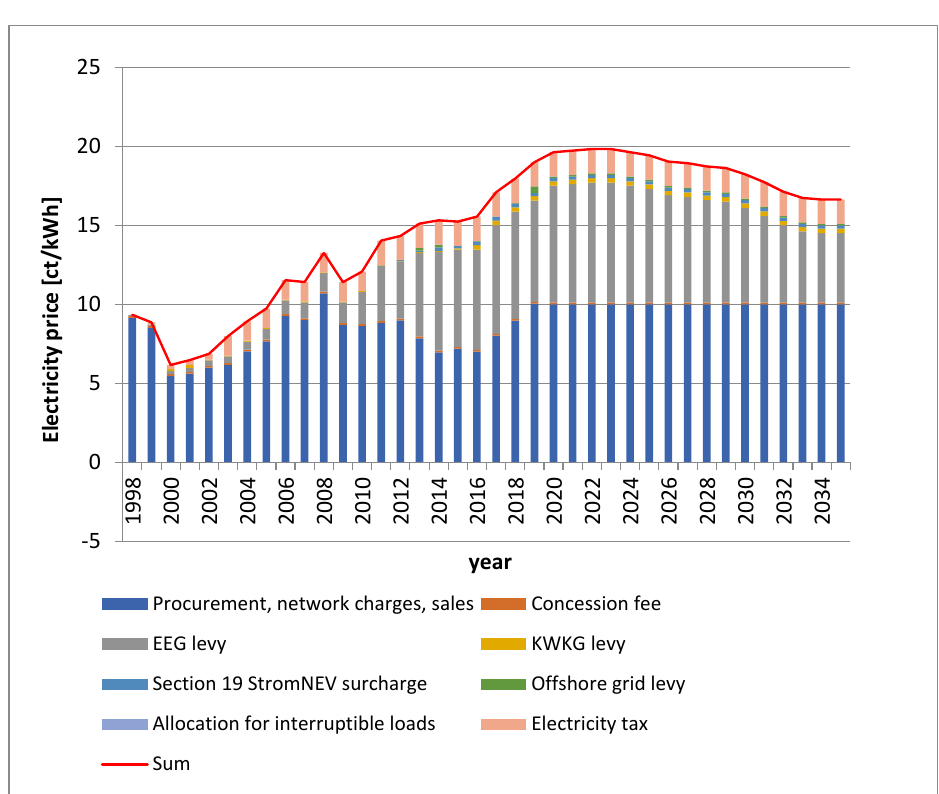
Figure 9. BDEW electricity price analysis 1998 – 2019 and EEG surcharge changes up to 2035, and 1 ct (cent) defined as 0.01 € .